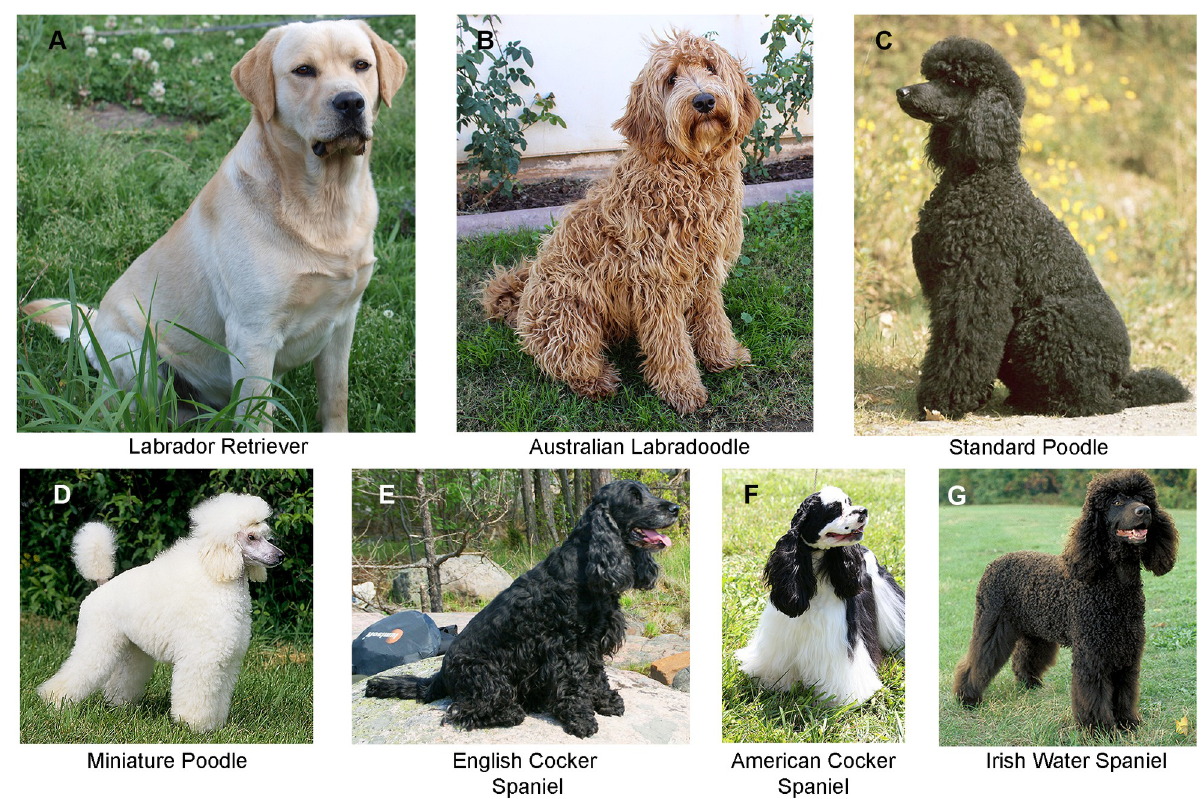
Fig 1. Pictures of the breeds under consideration in this study. (A) Labrador retriever (LAB), (B) Australian labradoodle (ALBD), (C) standard poodle (SPOO), (D) miniature poodle (MPOO), (E) English cocker spaniel (ECKR), (F) American cocker spaniel (ACKR) and (G) Irish water spaniel (IWSP). When all poodle breeds were considered as one group the designation POOD was